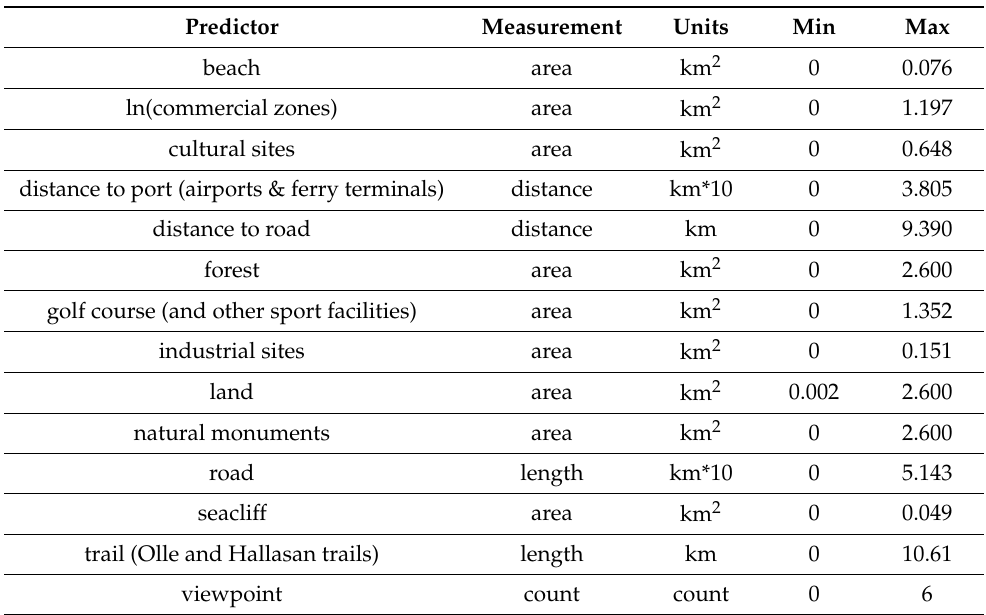
Table 1. Variables measured in the 2.6 km 2 grid cells and used as predictors in multivariate regression